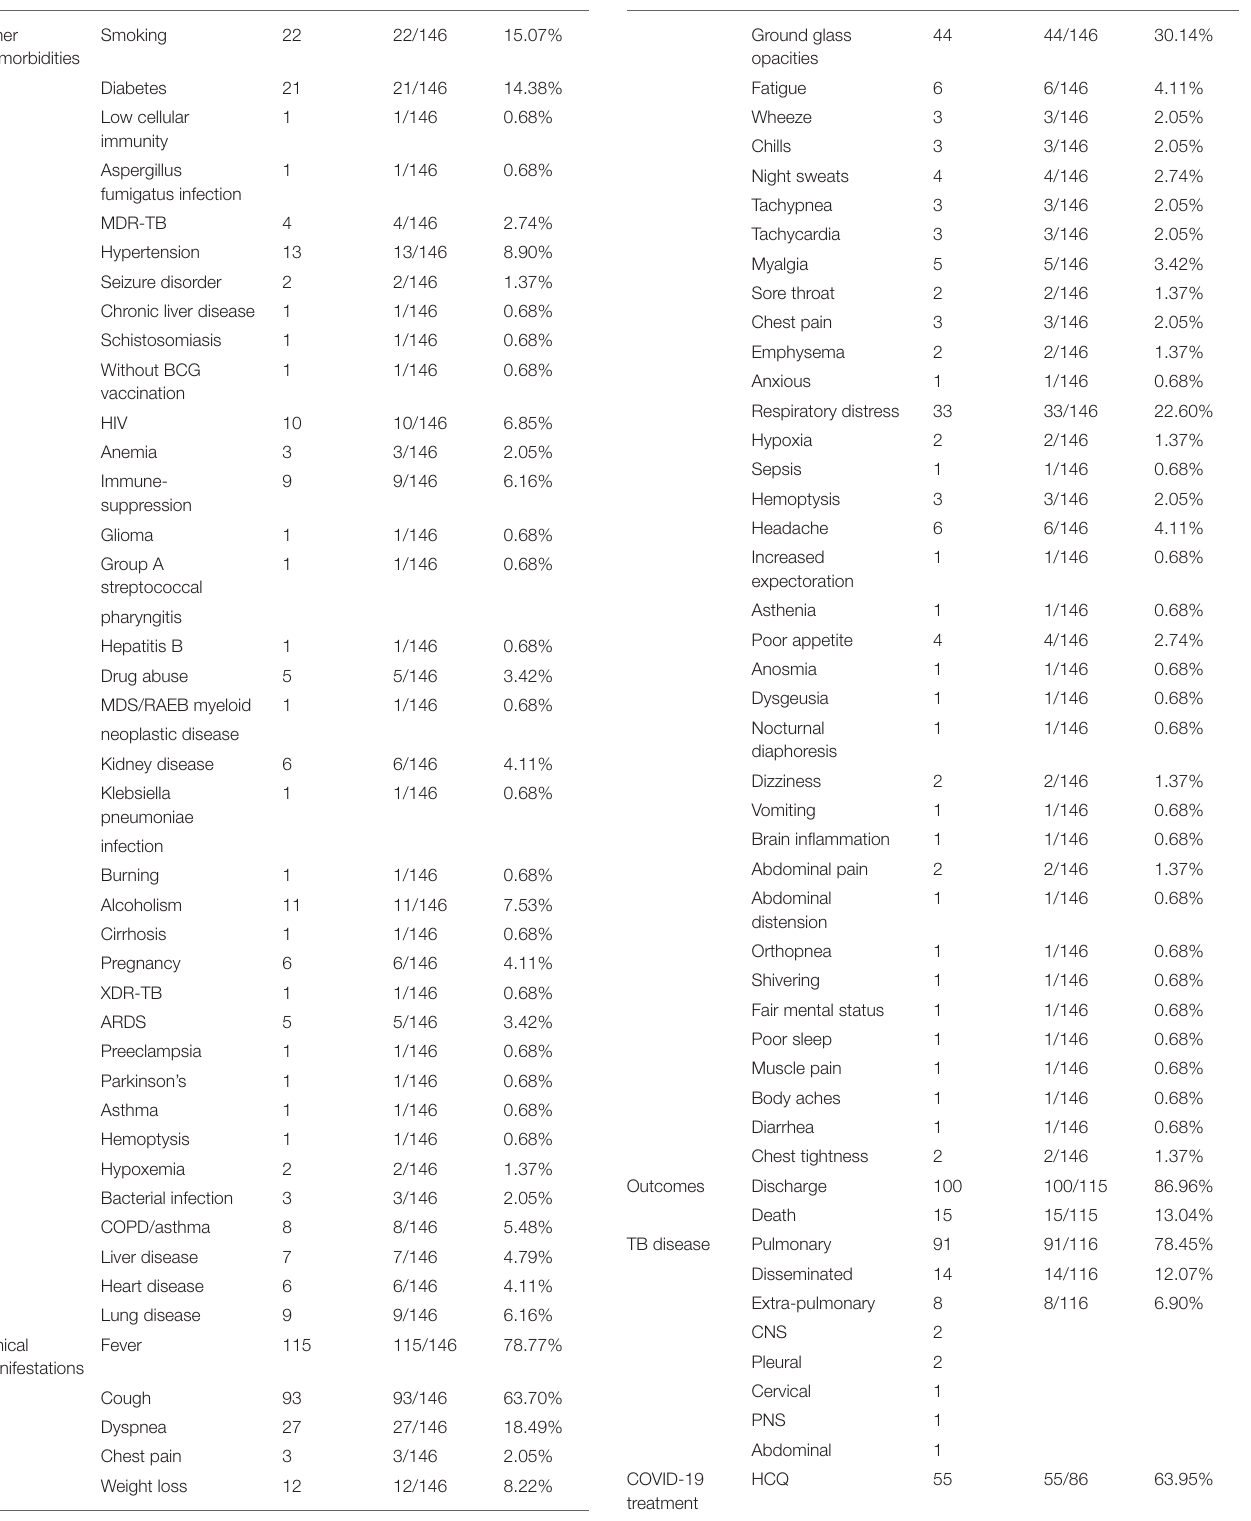
TABLE 2 | Summary of the case report and case series findings. Variables Other Comorbidities